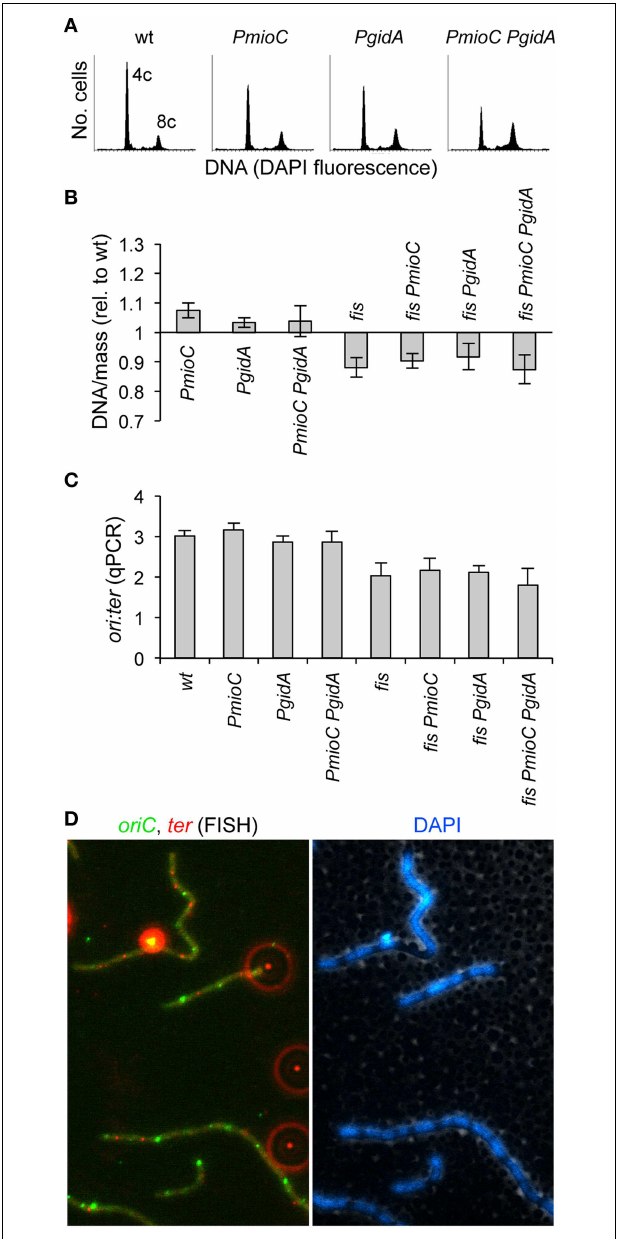
FIGURE 4 | Promoter mutations do not impair DNA replication or chromosome segregation. (A) Rifampicin runoff DNA histograms in PmioC and PgidA mutants indicate synchronous replication initiations. Numbers represent the number of chromosomes at the major peaks. (B) DNA/mass in exponentially growing cultures was measured by flow cytometry of DAPI stained cells (values are relative to wildtype ). (C) The ratio of oriC sites to ter sites in above cells was measured by qPCR, indicating the rate of DNA replication and whether replication forks were blocked between oriC and ter . Values in B,C are means of 3 independent experiments ( ± 1 SD). (D) The positions of oriC (green foci) and ter (red foci) in elongating triple mutant PmioC PgidA fis cells was analyzed by FISH (left panel). Bright extracellular foci (appearing as red halos) are multi-fluorescent beads added for image alignment. DAPI staining (right panel) indicates ter foci are located between segregated nucleoids, consistent with normal chromosome segregation (Text). See Material and Methods for